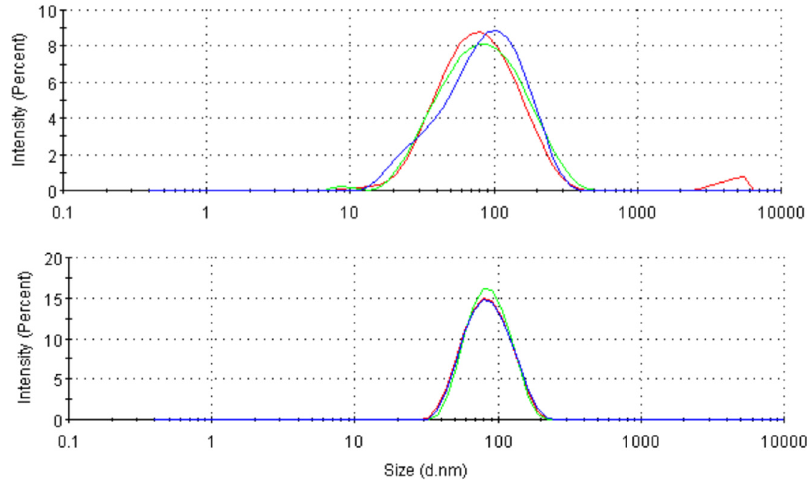
Figure 2. The hydrodynamic size distribution of MnMEIO NPs ( A ) and MnMEIO-Ex NPs ( B ). Three curves in black, green and red indicate three measurements.